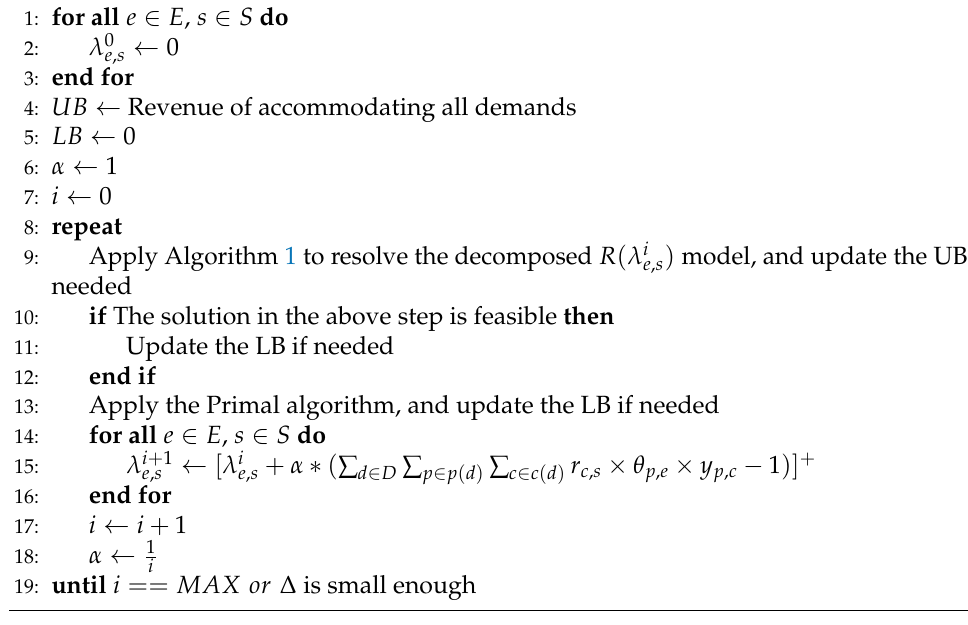
Algorithm 3 The Primal-Dual Framework for the ROR